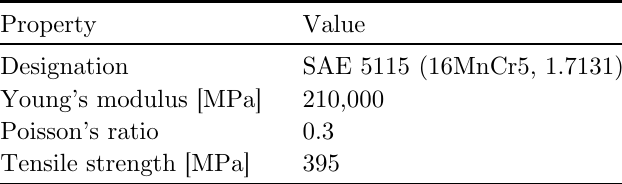
Fig. 3. Simulation steps to join the shaft and hub for contact-stress investigation. Table 1. Material properties of the formed shaft.